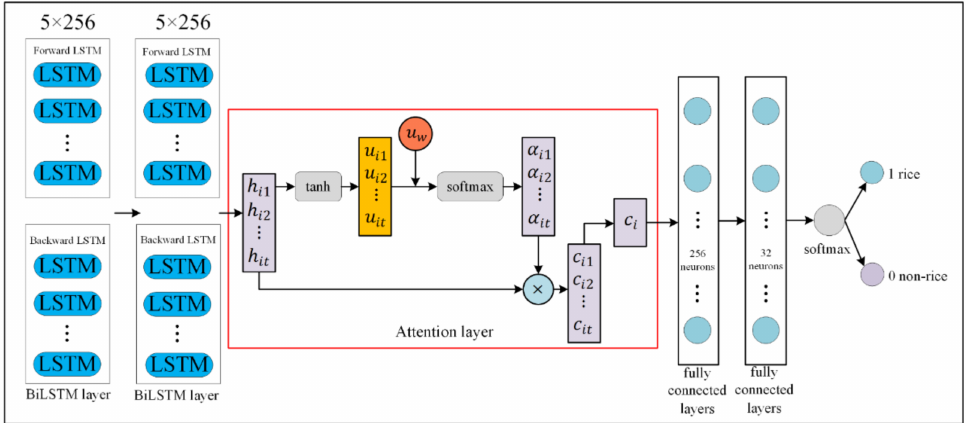
Figure 10. Structure diagram of BiLSTM-Attention